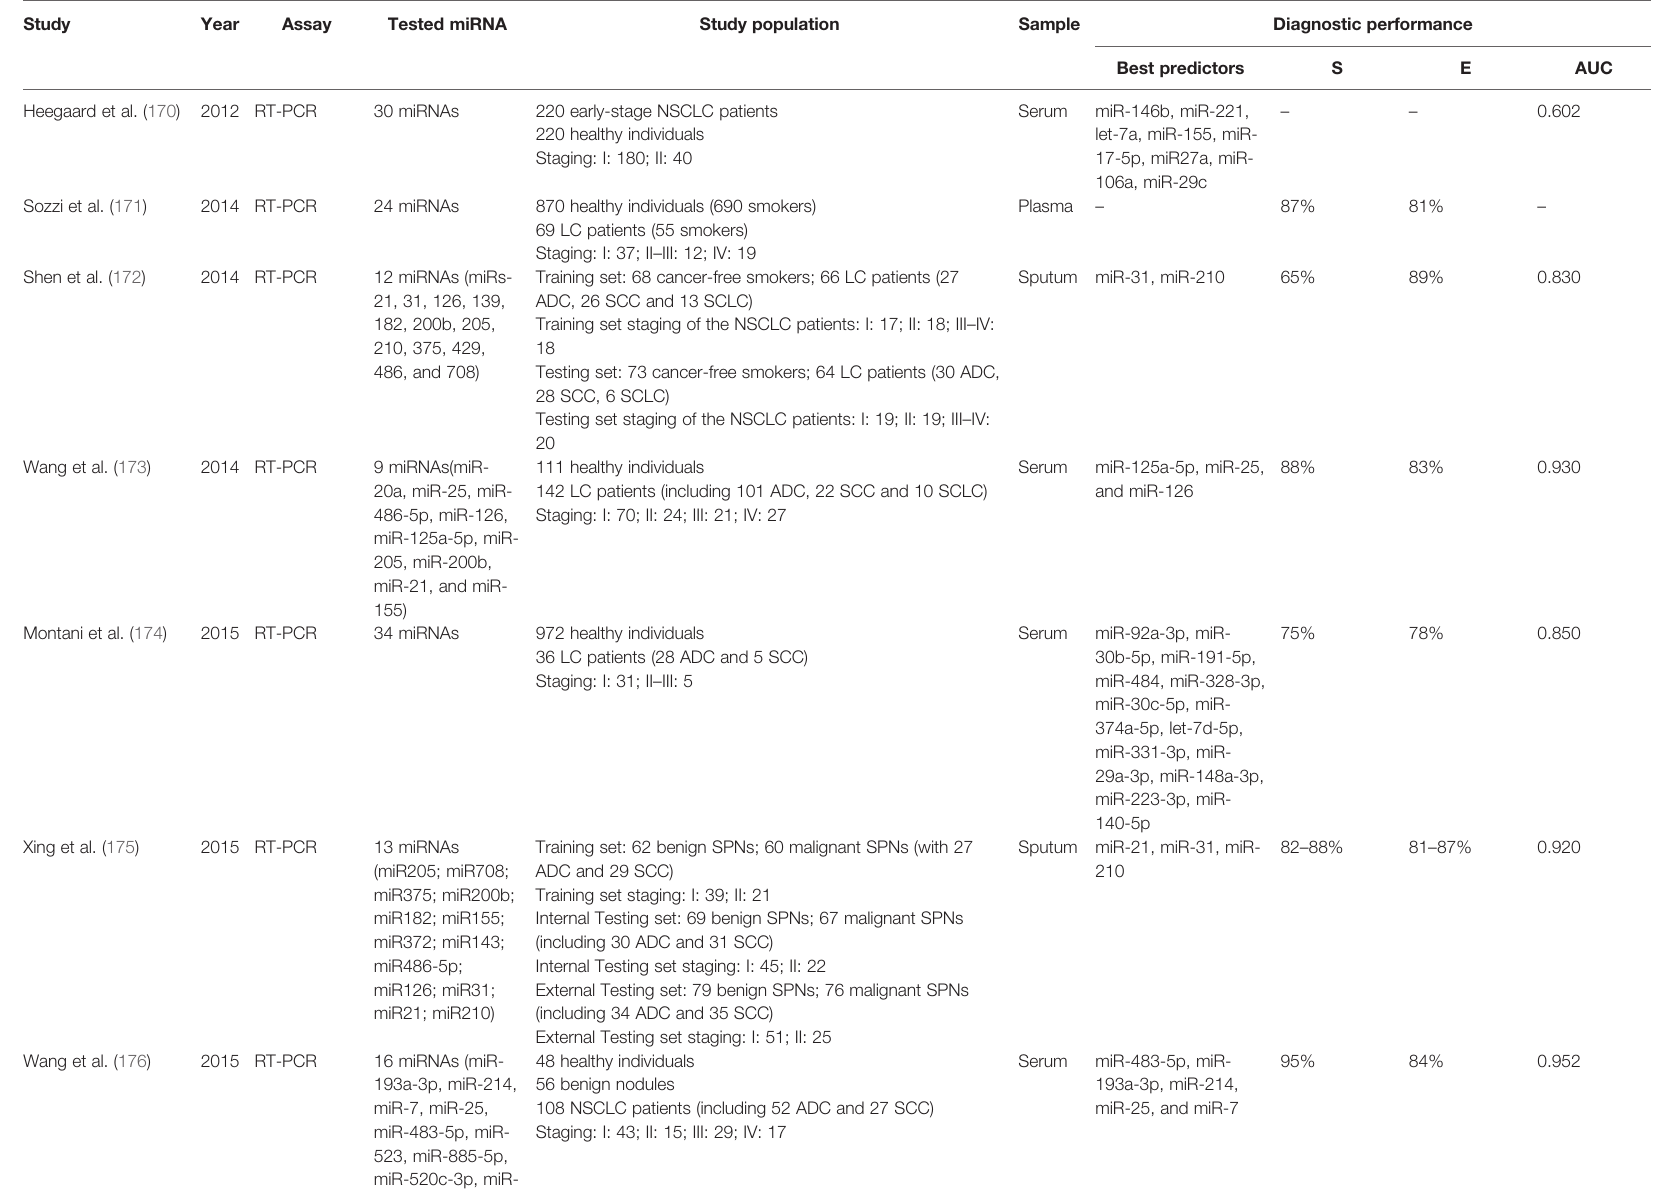
Training set: 68 cancer-free smokers; 66 LC patients (27 ADC, 26 SCC and 13 SCLC) Training set staging of the NSCLC patients: I: 17; II: 18; III – IV: 18 Testing set: 73 cancer-free smokers; 64 LC patients (30 ADC, 28 SCC, 6